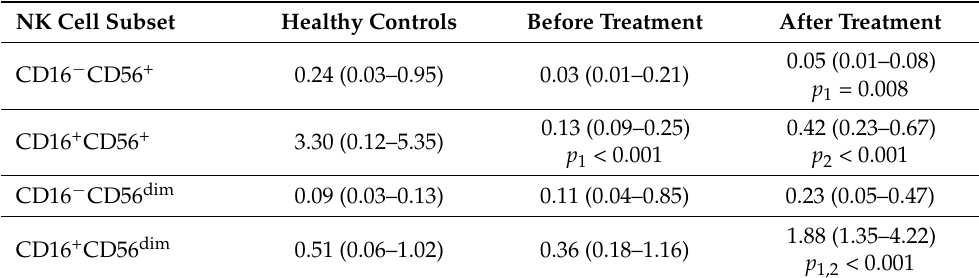
Table 3. CD57 expressed on diverse NK cell subsets (%) in convalescent COVID-19 individuals before and after recombinant human IL-2 treatment (Me (IQR)).